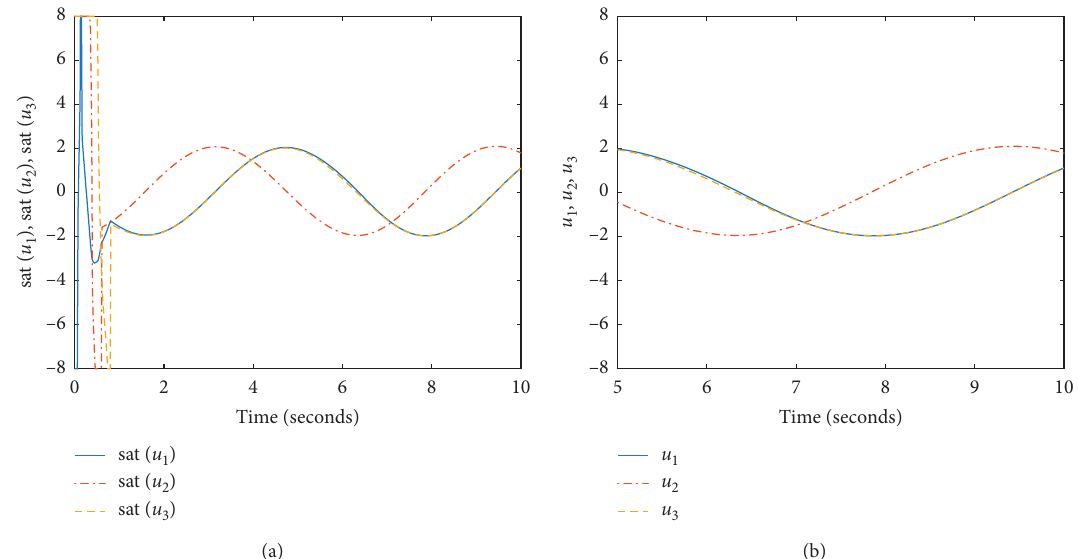
) , sat ( u ) , sat ( u ) by method (12) in time period [0, 10s] and (b) u 1 2 3